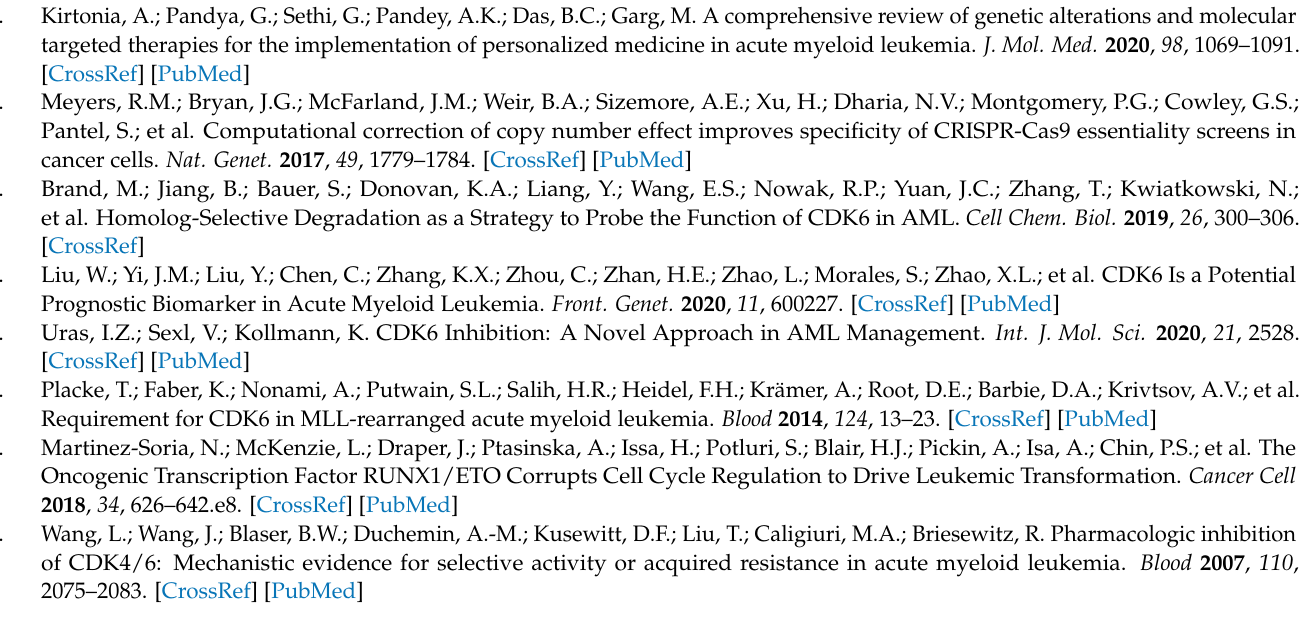
of INK4 low cells, Figure S3: BSJ efficacy depends on INK4 protein levels, Figure S4: INK4 levels as predictive markers for CDK6 degrader, Figure S5: Original uncropped immunoblot scans, Figure S6: Plasmid maps, Supplementary Methods, Table S1: Primer sequences for qPCRs, Table S2: Antibodies used in this study. And a detailed method description of liquid chromatography coupled with tandem mass spectrometry (LC-MS/MS) [39–42], Table S3: Raw and normalised mass spectrometry (LC-MS/MS)